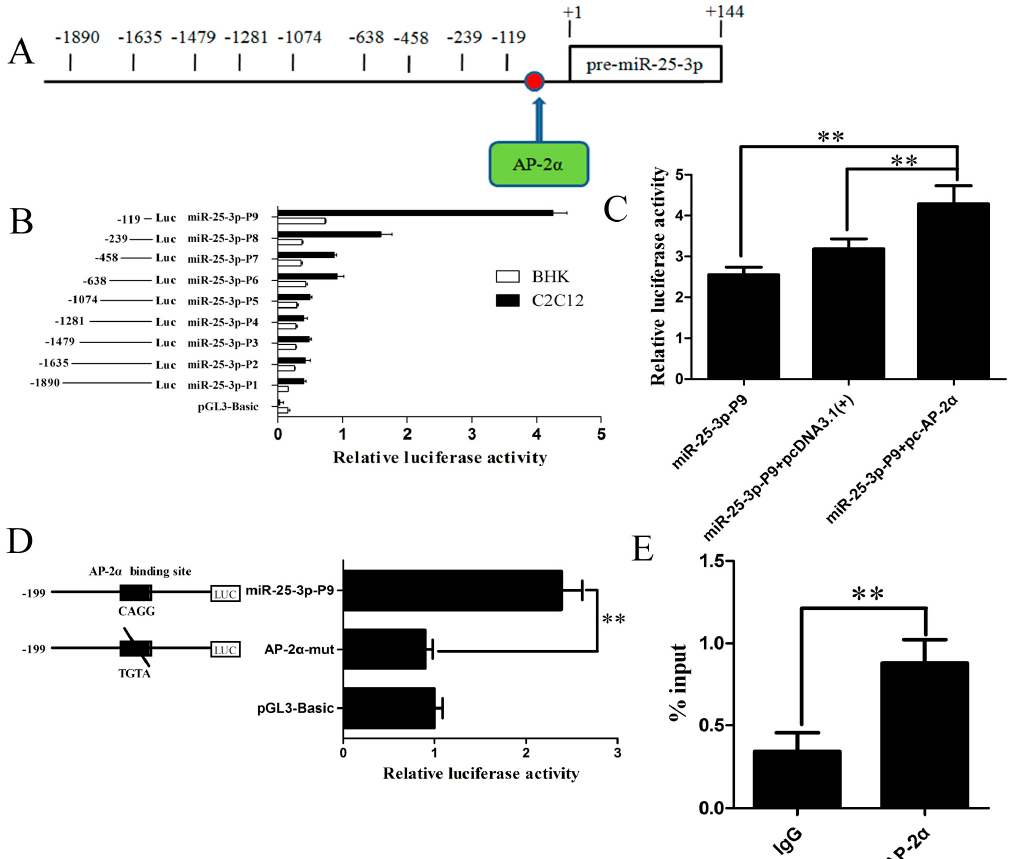
Figure 4. Transcription factor AP-2 α binds to the miR-25-3p promoter region. ( A ) Schematic diagram of the AP-2 α binding site (arrow, red dot) in the miR-25-3p promoter. The first nucleotide of pre-miR-25-3p was assigned as +1, and the other nucleotides were numbered relative to it. ( B ) A series of progressive deletion mutants were transfected into growing BHK and C2C12 cells, and the promoter activities were analyzed by dual luciferase activity assay. ( C ) miR-25-3p-P9 reporter constructs were cotransfected with pc-AP-2 α into growing C2C12 cells. Dual luciferase activity was measured 24 h after transfection. Overexpression of AP-2 α upregulated miR-25-3p promoter luciferase activity. pcDNA-3.1(+) was used as a control. ( D ) Site-directed mutagenesis of the AP-2 α binding site (CAGG into TGTA) in the miR-25-3p promoter region resulted in the miR-25-3p-P9 luciferase activity being reduced. Data were expressed as the ratio of relative activity, normalized to pRL-TK, and presented as means± SD ( n ≥ 3). ( E ) Binding of AP-2 α to the miR-25-3p promoter region was analyzed by chromatin immunoprecipitation (ChIP). DNA isolated from immunoprecipitated materials was amplified using qRT-PCR. Normal mouse IgG was used as the negative control. Data were normalized by total chromatin (input) and presented as means ± SD ( n = 3); ** p < 0.01.